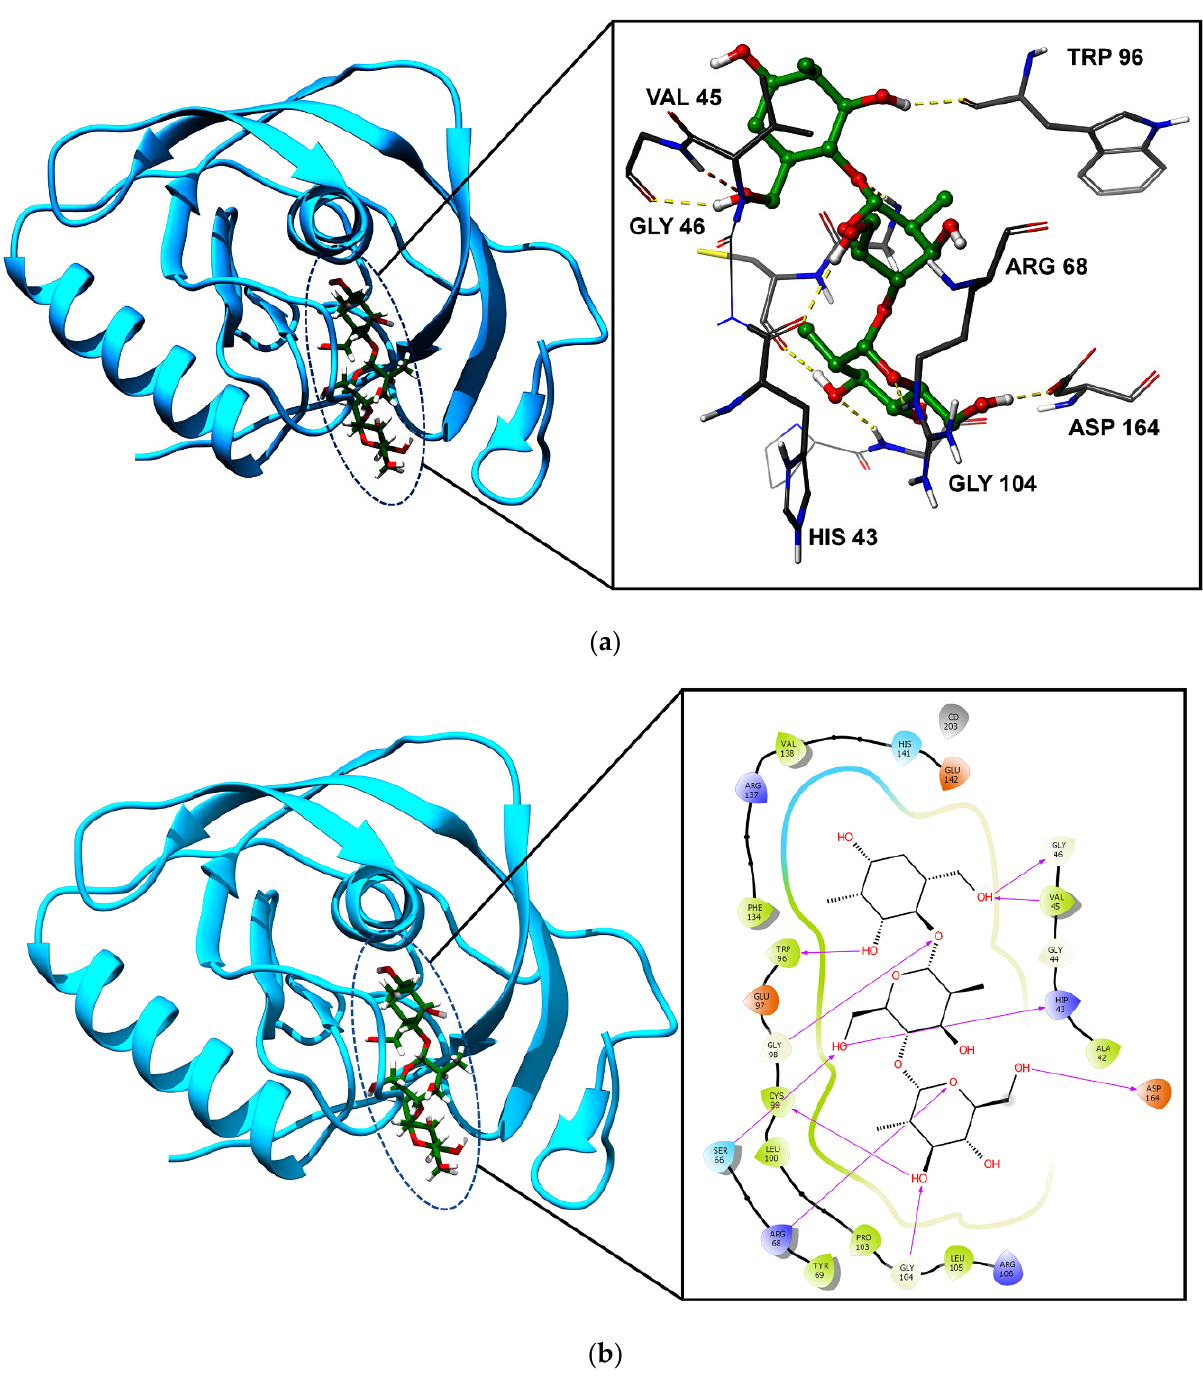
Figure 11. ( a ) 3D representation of protein–polymer interactions, showing ligands in a ball and stick model and core active sites in a stick model, surrounded by a ribbon model. ( b ) Two-dimensional representation of protein–polymer interactions, showing amino acids with a charge-based color model.